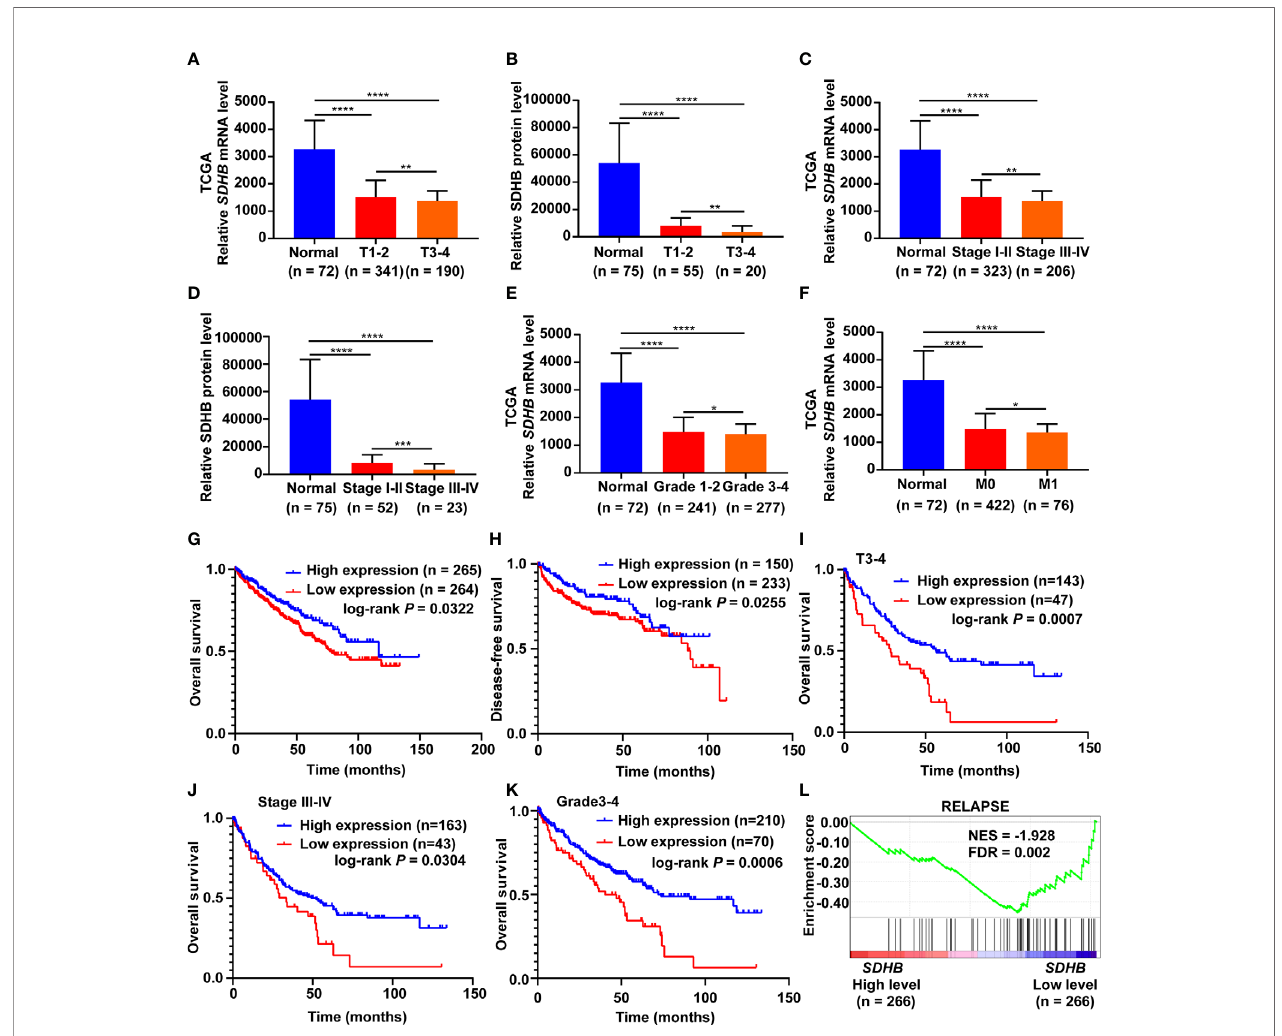
FIGURE 2 | SDHB is a potential prognostic marker for ccRCC patients. (A – E) SDHB mRNA and protein levels were gradually downregulated as T stage, AJCC stage and Fuhrman grade progressed. (F) SDHB mRNA level was negatively correlated with distant metastasis of ccRCC patients. (G, H) The Kaplan-Meier (KM) curves of overall survival and disease-free survival based on TCGA_KIRC data. ccRCC patients were divided into high/low expression groups according to SDHB mRNA level. (I – K) KM curves of overall survival based on TCGA_KIRC data. Advanced ccRCC patients were divided into high/low expression groups according to SDHB mRNA level. (L) Enrichment plot of gene expression signature for relapse (KAUFFMANN_MELANOMA_RELAPSE_UP) was obtained by GSEA according to SDHB mRNA levels. The ccRCC samples from TCGA_KIRC database were divided into high and low SDHB expression groups according to the median value of SDHB RNA-seq quanti fi cation results. * P < 0.05; ** P < 0.01; *** P < 0.001; **** P <